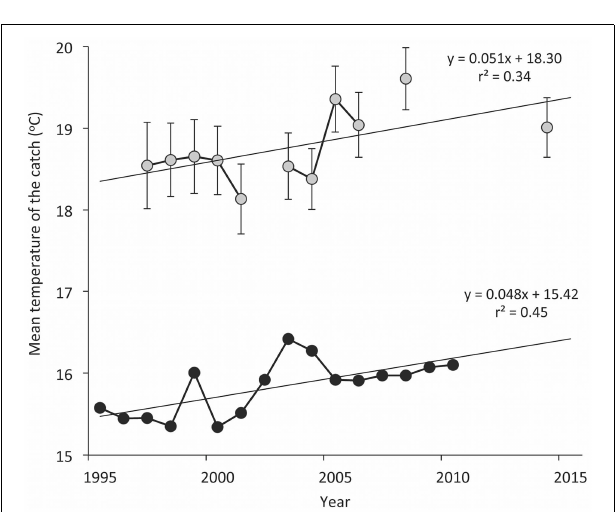
in the underlying area plot (blue area: species preferring colder waters; red area: species preferring warmer waters). The cut-off temperature value was set at 20 ◦ C because this is the average inferred temperature preference for all species in the dataset.